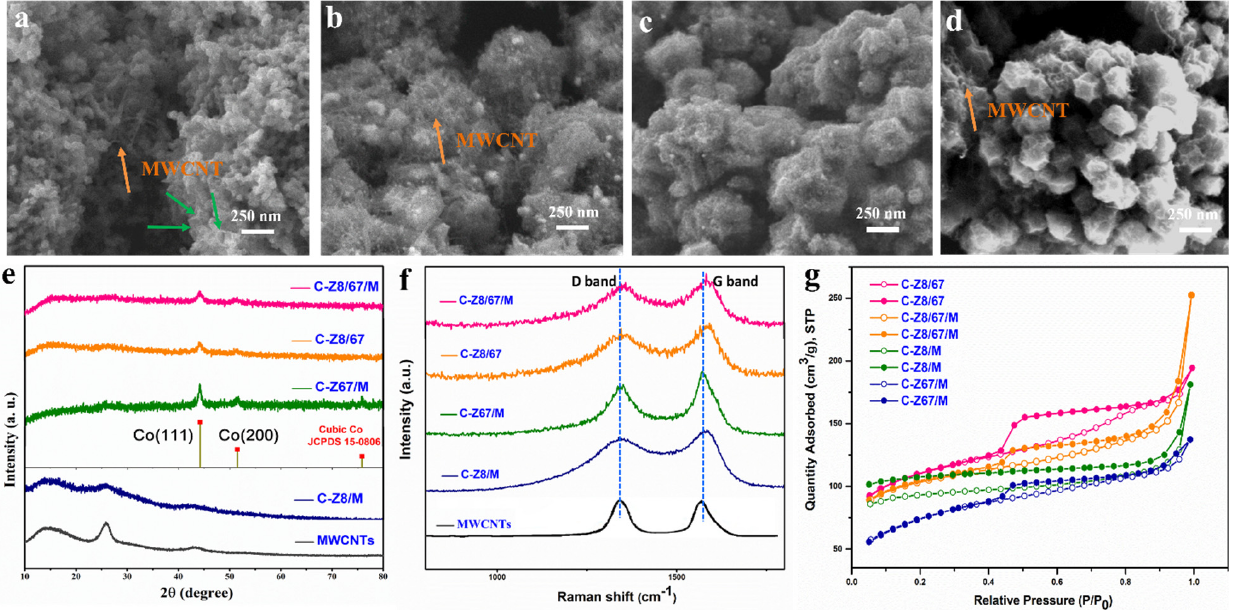
Figure 1. ( a – d ) SEM of C-Z8/M, C-Z67/M, C-Z8/67 and gl-CNTs/Co@N-C (orange arrows mark MWCNT and green arrows mark hollow carbon particles); ( e – g ) XRD, Raman patterns, and N 2 ad- Table 1. Specific surface area and pore parameters of different samples.